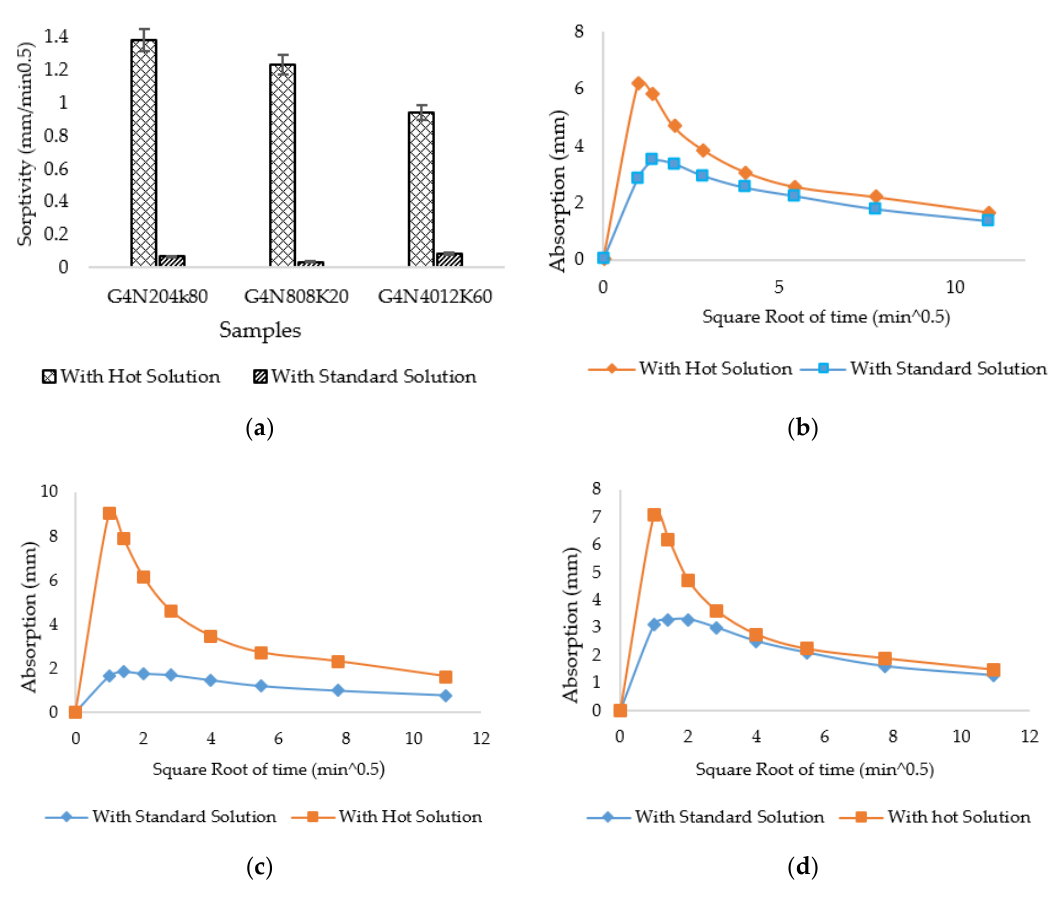
Figure 16. Comparison of ( a ) sorptivity values at 28 days, ( b ) absorption rate of G4N 20 4K 80 , ( c ) absorption rate of G4N 80 8K 20 , and ( d ) absorption rate of G4N 40 12K 60 .